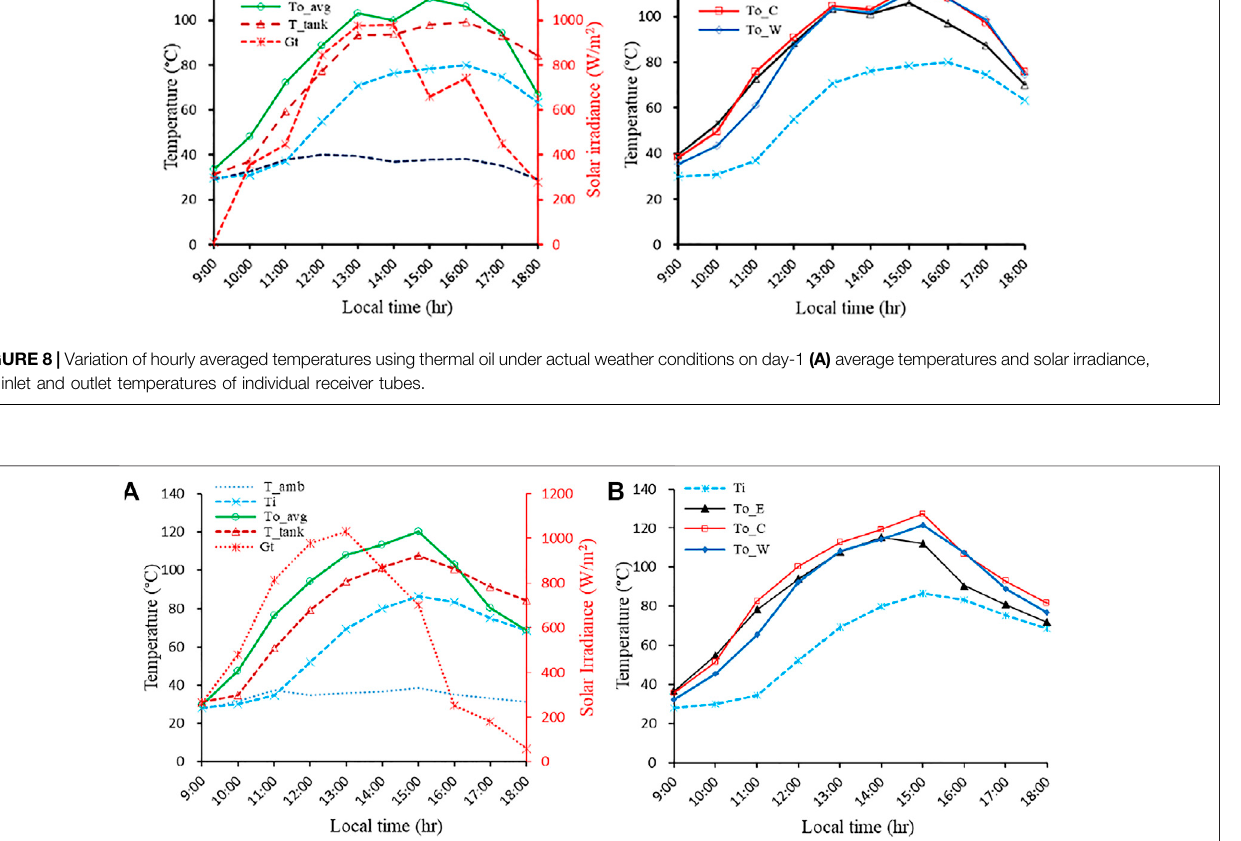
FIGURE 9 | Variation of hourly averaged temperatures using thermal oil under actual weather conditions on day-2 (A) average temperatures and solar irradiance, (B) inlet and outlet temperatures of individual receiver tubes.